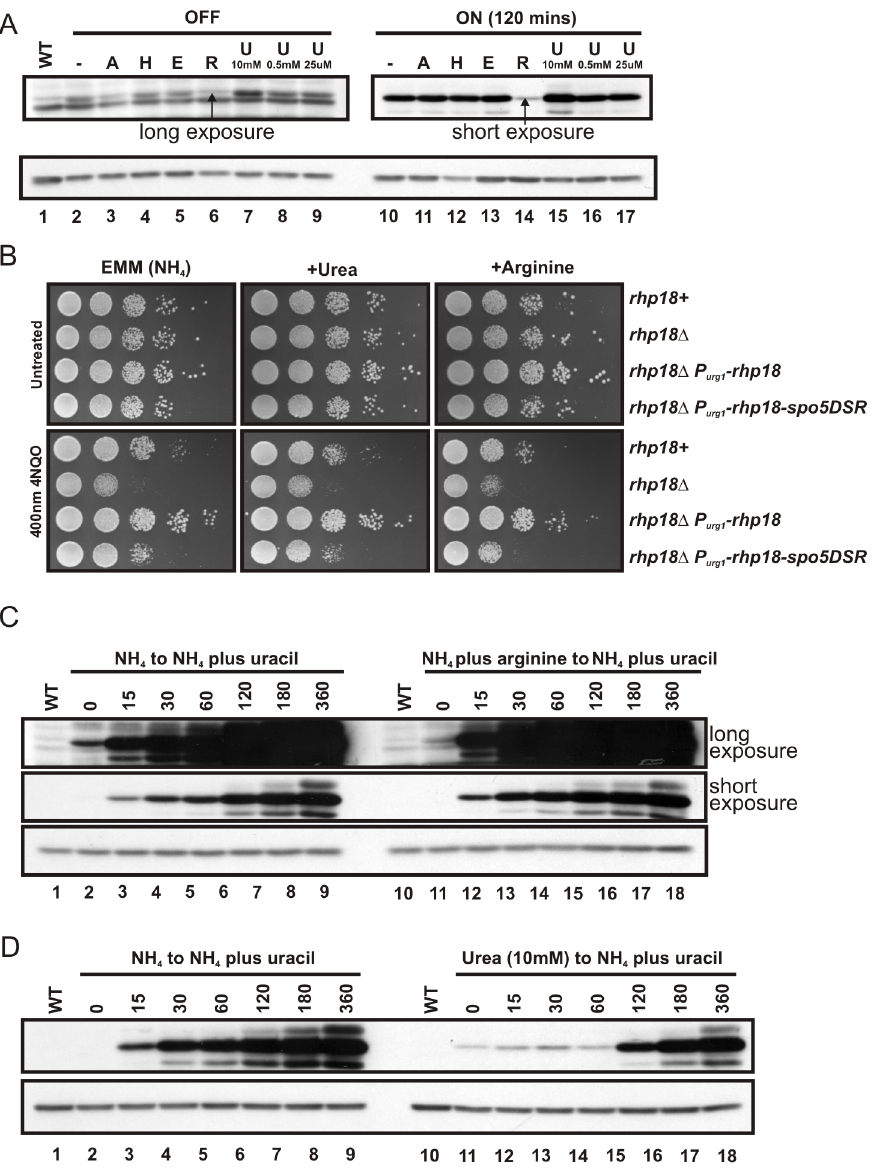
Figure 6. The effect of arginine and urea on P urg1lox expression levels. ( A ) Arginine reduces both P urg1lox induced and repressed protein levels. AW640 ( P urg1lox -cyEGFP ) cells were grown in EMM + L or EMM + L supplemented with adenine (A), histidine (H), arginine (R), EMM media where NH 4 Cl was substituted for 22 mM glutamic acid (E), EMM media where NH 4 Cl was substituted for urea at 10 mM (U 10 mM) or EMM media supplemented with urea at 0.5 mM (U 0.5 mM) or 25 m M (U 25 m M). Cells were induced by the addition of uracil at 0.25 mg/ml and cells grown for 2h. A long exposure of the P urg1lox OFF and a short exposure of the P urg1lox ON are shown. Arrows mark band of interest. ( B ). Strains AW617 ( rhp18 + ), YDP273 ( rhp18 D ), YDP210 ( rhp18 D , P urg1lox -rhp18 ) and YDP231 ( rhp18 D , P urg1lox -rhp18-spo5DSR ) were serially diluted 10-fold in water and spotted on EMM + L plates or supplemented as shown with urea at 25 uM or arginine at 100 m g/ml, with or without 4NQO at 400 nM. Time of incubation at 30 u C was 3 days. ( C ). The induction kinetics of P urg1lox is improved when cells are pre-cultured in EMM supplemented with arginine. AW640 ( P urg1lox -cyEGFP ) cells were pre-cultured in EMM + L or EMM + L supplemented with arginine at 100 m g/ml (P urg1lox OFF). Cells were pelleted by centrifugation, washed twice in EMM + L and re-suspended in EMM + L containing uracil at 0.25 mg/ml (P urg1lox ON). Samples taken at time-points shown (mins). ( D ). The induction kinetics of P urg1lox is significantly delayed when cells are pre-cultured in the presence of urea. AW640 ( P urg1lox -cyEGFP ) cells were pre- cultured in EMM + L or EMM + L where the nitrogen source is 10 mM urea (P urg1lox OFF). Cells were pelleted by centrifugation, washed twice in EMM + L and re-suspended in EMM + L containing uracil at 0.25 mg/ml (P urg1lox ON). Samples taken at time points shown (mins). For (A), (C) and (D), total protein extracts were separated by SDS PAGE prior to Western blotting using anti-GFP to detect yEGFP (upper panels) and anti-tubulin to detect tubulin as a loading control (lower panel). WT represents control strain AW501 ( h 2 , leu1-32 ). doi:10.1371/journal.pone.0083800.g006 and is induced within 30 minutes by a simple media manipulation: disadvantages: first it does not work well outside of its normal the addition of uracil, which does not otherwise significantly alter locus; second, its basal level of transcription is relatively high; and cell physiology. However, P urg1 does suffer from a number of third, it is induced during meiosis. In previous work [7] we